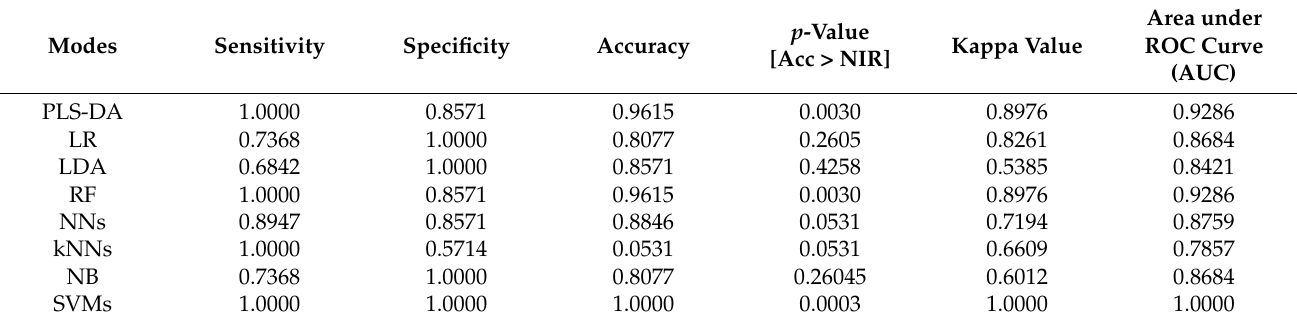
Figure 3. The results of ANOSIM and NMDS analyses of the content of multi-element in P. notoginseng from different cultivation models. ( a ) The analysis of similarities (ANOSIM, using Bray-Curtis similarity distance matrix) of the multi-element content from cultivation models. ( b ) the results of the non-metric multidimensional scaling (NMDS, using the Bray–Curtis similarity distance matrix) of the multi-element content from cultivation models. Table 2. The major parameters of models of each class based on the content of multi-element in P. notoginseng under different planting